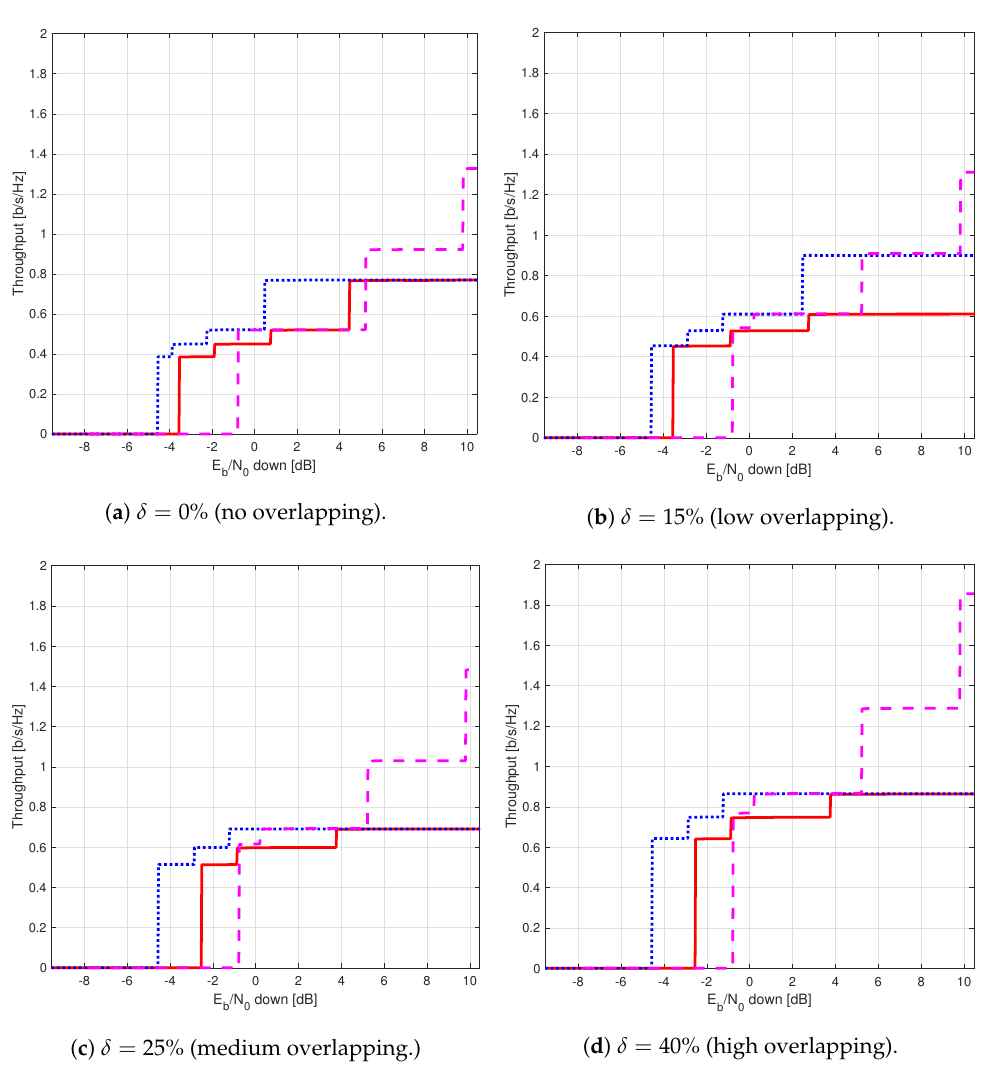
Figure 15. End-to-end envelope of throughput for all cases under study versus E b / N 0 in the access link. Case 1 (continuous red line), Case 2 (dotted blue line) and Case 3 (dashed magenta line). Wind speed: v = 21 m/s. Diameter of telescope aperture: W 0 =